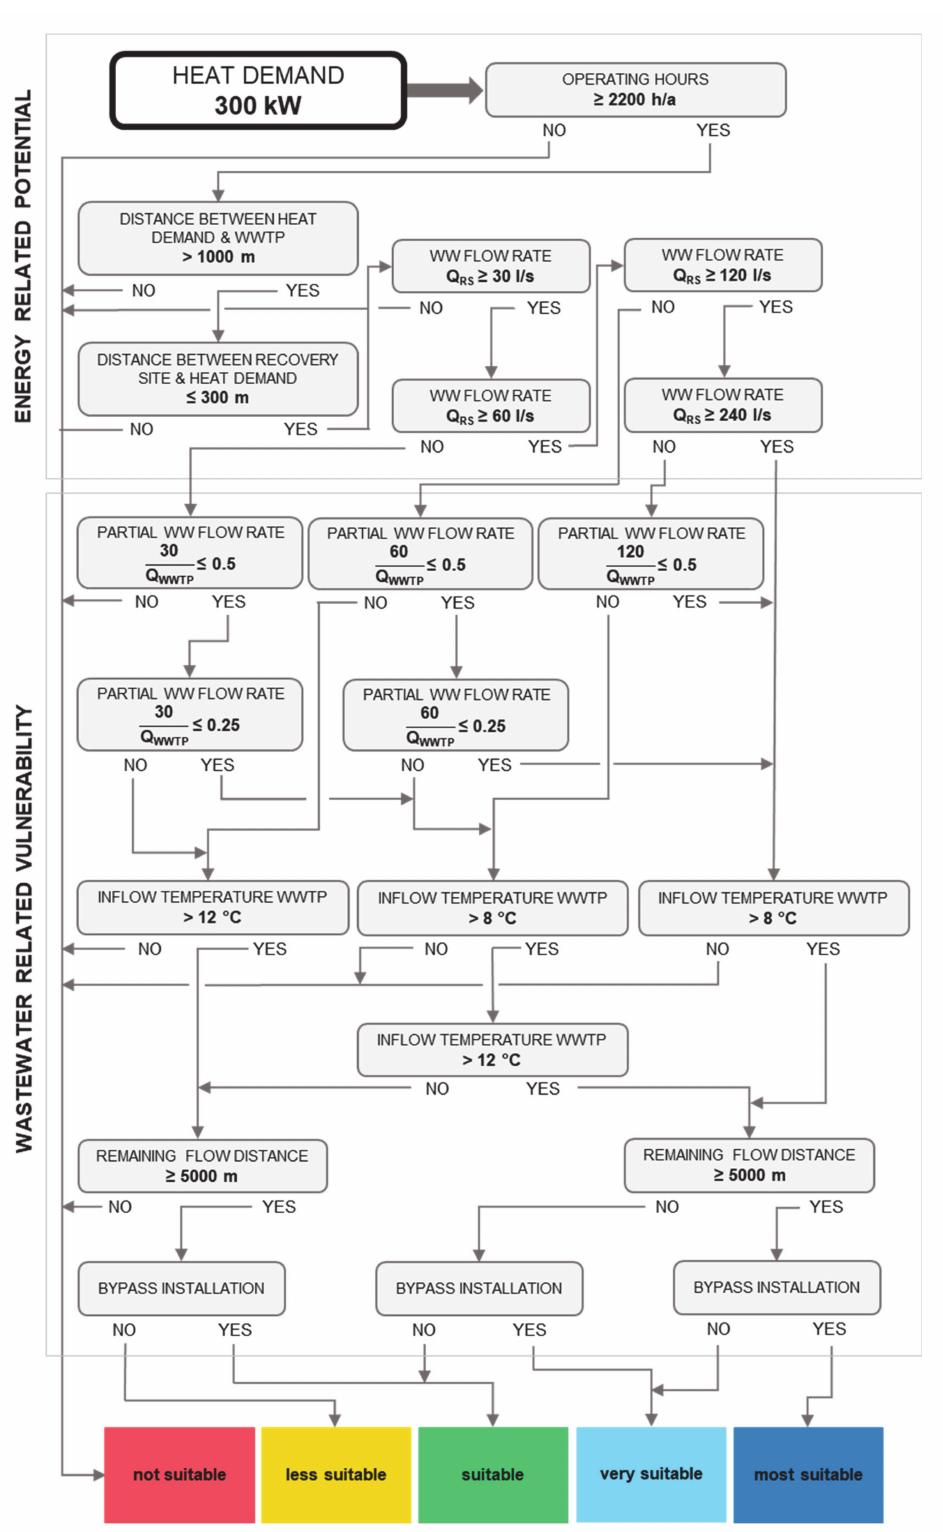
Figure A9. Relevance tree for an intended heat supply of 300 kW (own representation, based on